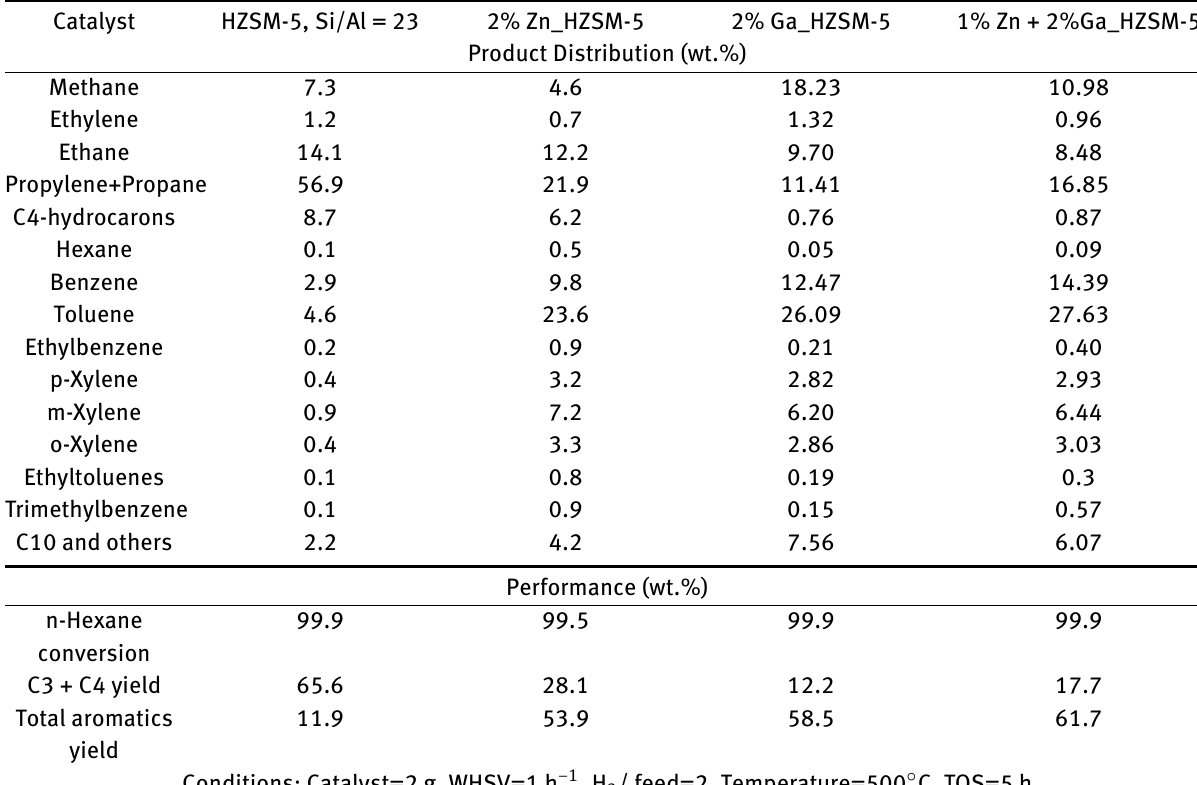
Table 12: The effect of metals on catalyst performance of ZSM-5 in aromatization of n-hexane